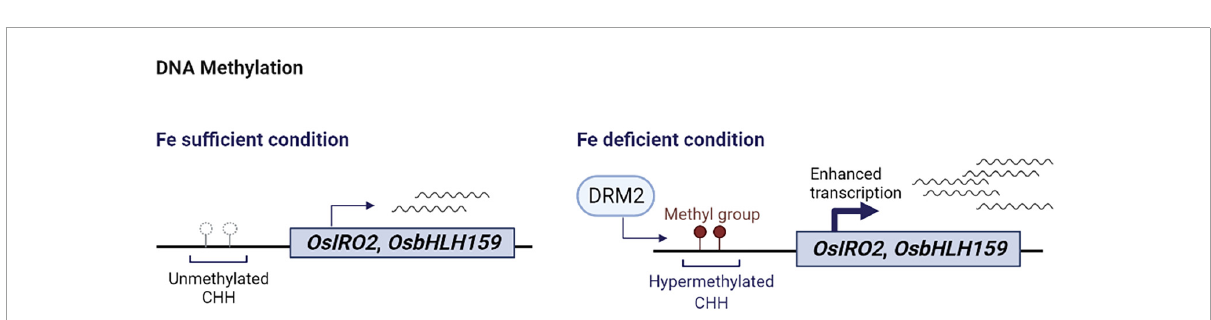
FIGURE2 Schematic summary of DNA hypermethylation and iron deficiency response in rice. Under iron sufficient conditions, the CHH sequences of OsIRO2 and OsbHLH159 promoters remain unmethylated and basal levels of OsIRO2 and OsbHLH159 are expressed. Upon iron deficiency, hypermethylation of CHH nucleotides on the promoters of OsIRO2 and OsbHLH159 by DRM2 leads to activation of the expression of the corresponding downstream genes in response to iron deficiency. This figure was created with